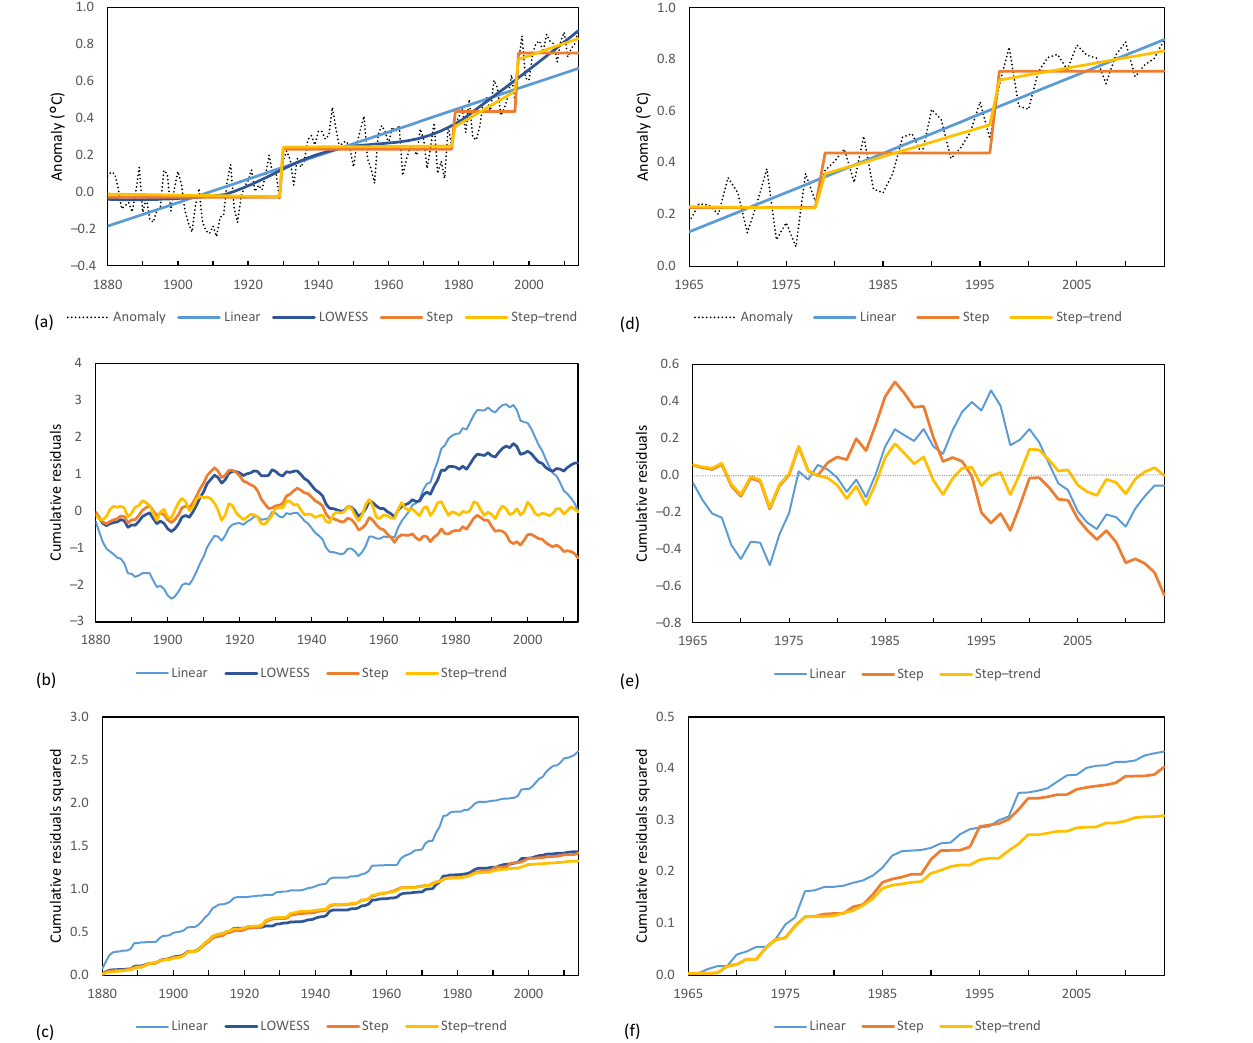
Figure 12. Testing three models to mean global anomalies of surface temperature from the HadCRU record for 1880–2014 (a–c) and 1965– 2014 (d–f) ; (a) and (d) mean annual anomalies and linear step change and shift-and-trend models; (b) and (e) show cumulative residuals for each model, where success is measured as tracking close to zero; (c) and (f) show the cumulative sum of residuals squared, where upward steps show non-linearity not explained by each